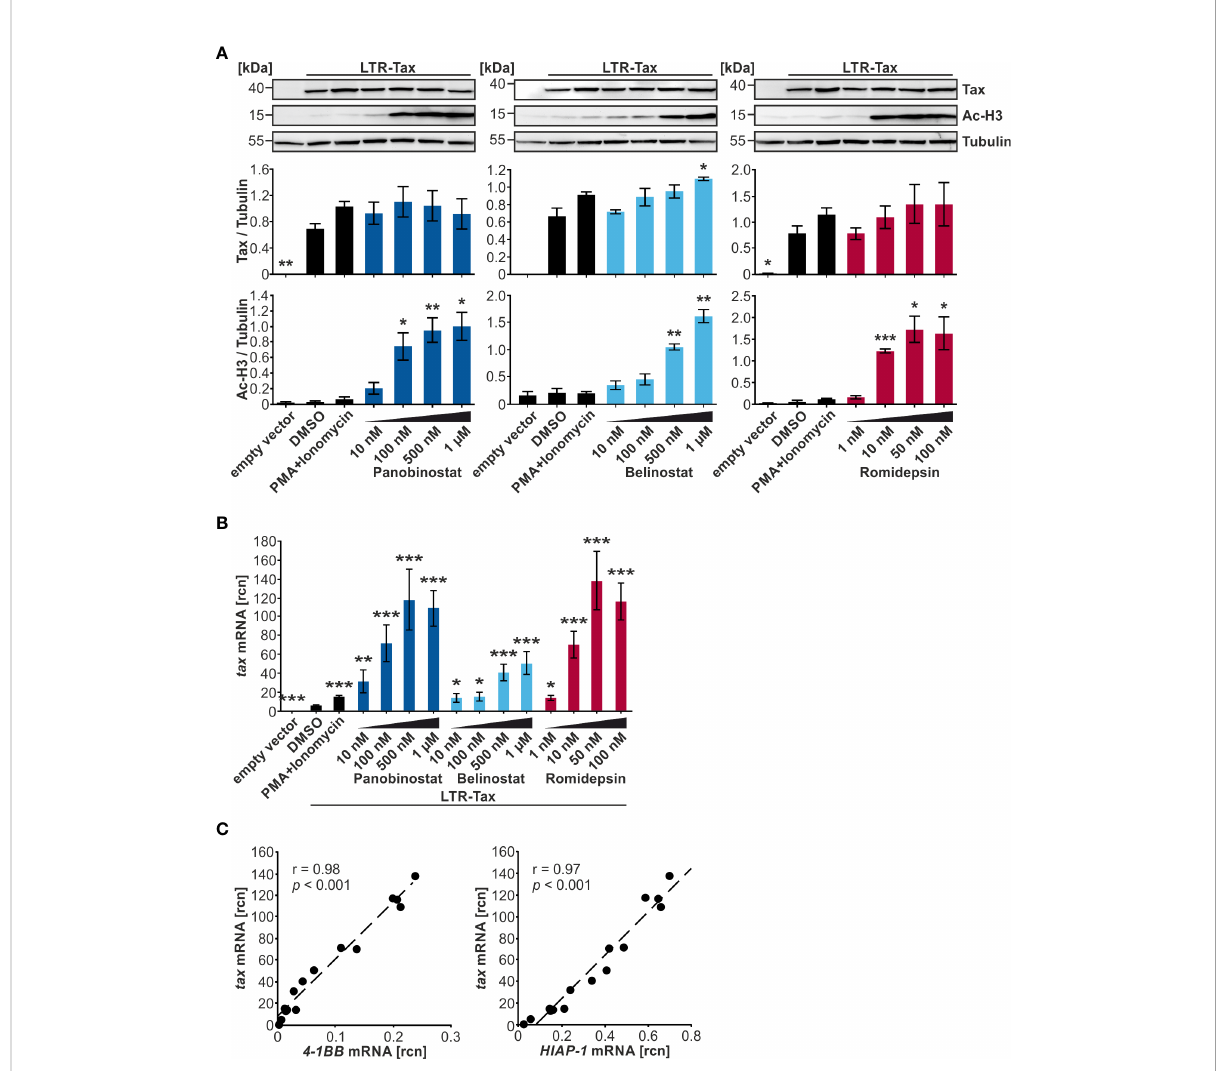
FIGURE 3 Despite a strong dose-dependent increase in histone acetylation, Tax protein is only slightly enhanced by HDACi in Jurkat T-cells. (A – C) Jurkat T-cells were transiently transfected with 15 µg LTR-Tax and fi lled with the empty vector DNA pEF1 a to 50 µg. Increasing doses of HDACi Panobinostat or Belinostat (10 nM, 100 nM, 500 nM, 1 µM), or Romidepsin (1nM, 10 nM, 50 nM, 100 nM) were added at 24 h post transfection for 24 h. PMA+Ionomycin served as positive control for activation of viral transcription and DMSO as solvent control. (A) Western Blot shows Tax protein, acetylated histone H3 (Ac-H3), and a -Tubulin (Tubulin) as the loading control. Densitometric analysis of Tax protein expression and Ac-H3, relative to Tubulin, of three independent experiments was performed. Mean values ± SE are depicted and HDACi treatment was compared to DMSO treatment using Student ’ s t-test (* p < 0.05; ** p < 0.01; *** p < 0.001). (B) Mean rcn of tax normalized to those of the housekeeping gene b -Actin of three independent experiments, and of nine independent experiments for the controls, ± SE are depicted, and values were compared to DMSO using Student ’ s t-test (* p < 0.05; ** p < 0.01; *** p < 0.001). (C) Mean rcn of tax and the Tax-target genes 4-1BB and HIAP-1 , normalized to the housekeeping gene b -Actin , were correlated and subjected to Pearson correlation analysis (Pearson correlation coef fi cient r = 0.98 and r = 0.97 respectively, p = 9.05E-12 and p = 2.90E-10